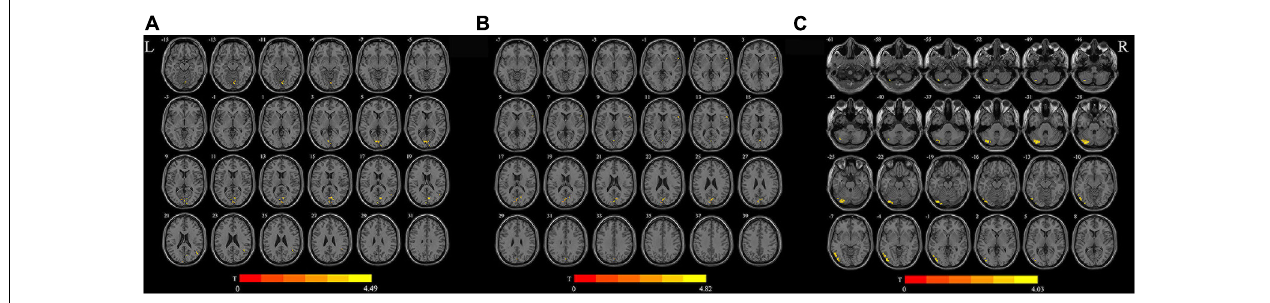
FIGURE 1 | Brain regions with significant differences in d-ALFF (A) , d-fALFF (B) , and d-ReHo (C) between the TIA group and the HC group (after GRF correction; voxel-wise p < 0.005, cluster-wise p < 0.05, two-tailed). The color bar indicates the T -value. L, left; R, right; d-ALFF, dynamic amplitude of low-frequency fluctuations; d-fALFF, dynamic fractional amplitude of low-frequency fluctuations; d-ReHo, dynamic regional homogeneity. TABLE 2 | Regions showing abnormal d-ALFF, d-fALFF, and d-ReHo in patients with TIA compared with HCs.